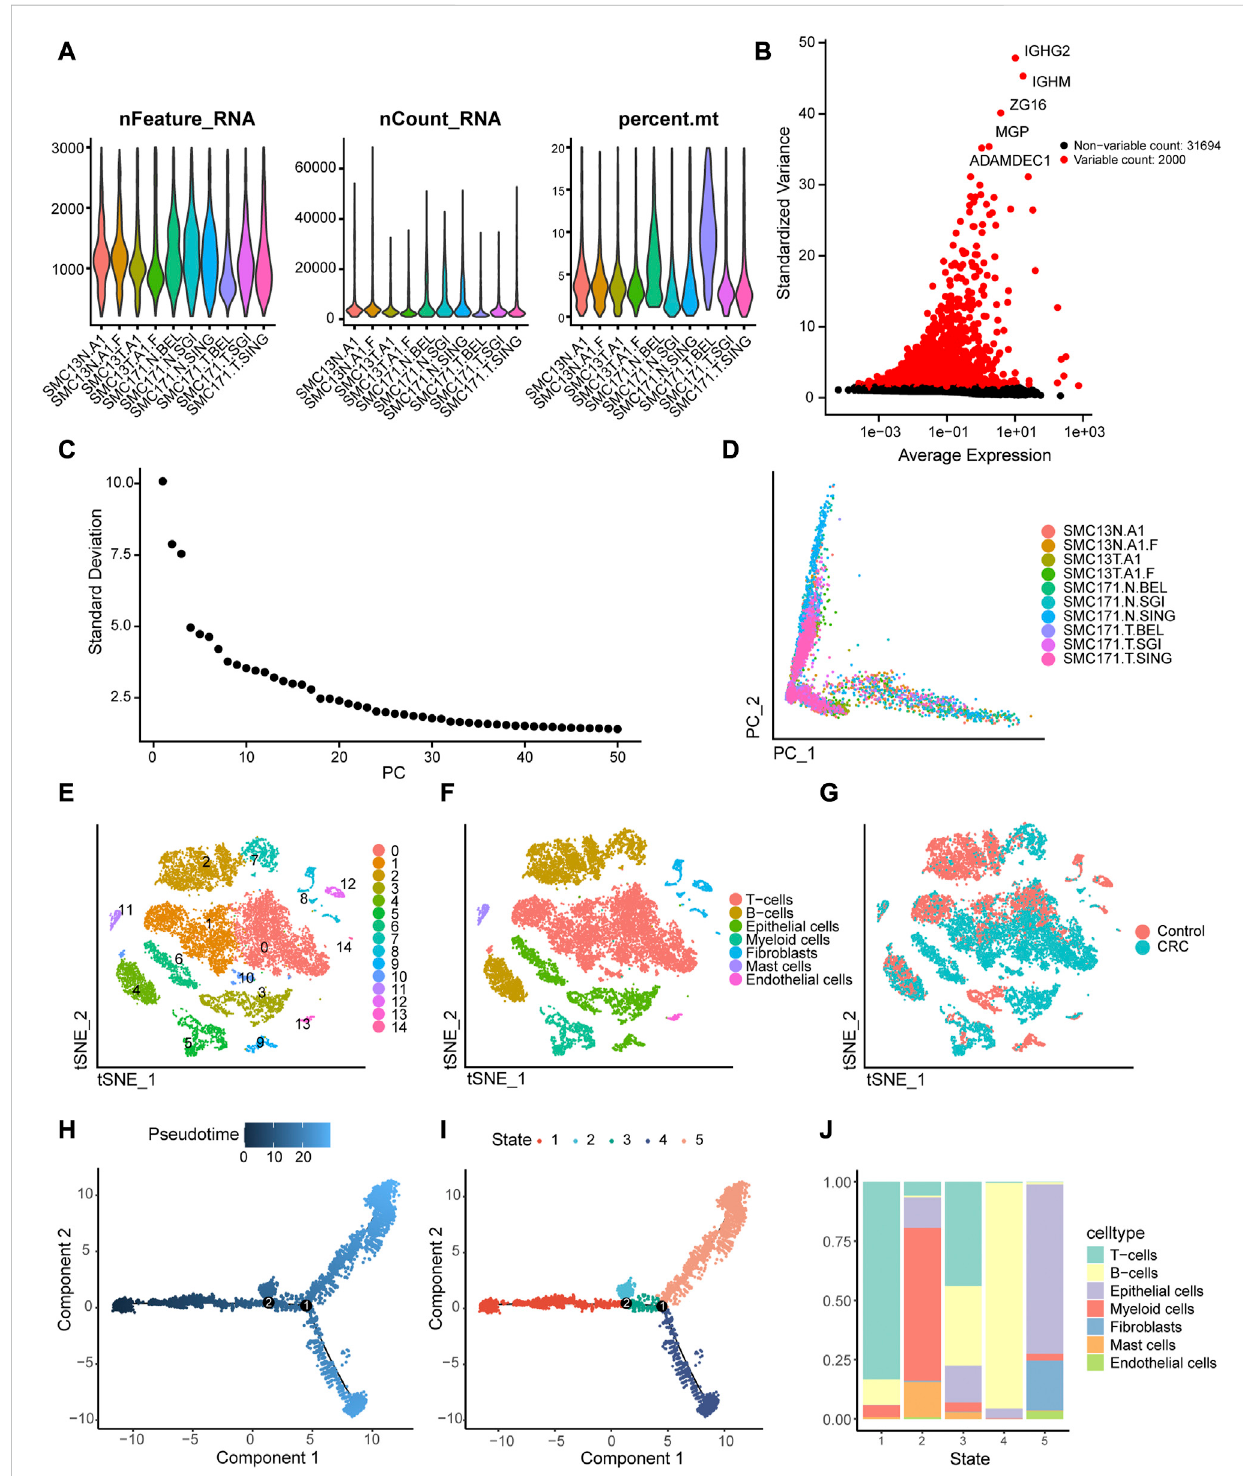
FIGURE 2 Identi fi cation of 15 cell clusters based on scRNA-seq. (A) Quality control of scRNA-seq for 10 samples from the GSE132257 dataset. A total of16, 270 cells were included for analysis. (B) Scatter plot displaying the hypervariable genes in cells. The top fi ve genes are indicated. (C) Elbow plot of the optimalnumberofprincipalcomponents(PC)forfurtheranalysis. (D) Distributionofcellsintheprincipalcomponent analysis(PCA). (E) Clusteranalysisof scRNA-seq. (F) Annotation the cell subpopulations using singleR package. (G) Distribution of the cells between colorectal cancer (CRC) and normal tissues. (I, J) Single-cell trajectories reconstruction reveals fi ve distinct Monocle stages, and pseudotime plot is colored based on pseudo-time (H) and Monocle stages (I) . (J) Proportions of different types of cells in the fi ve Monocle